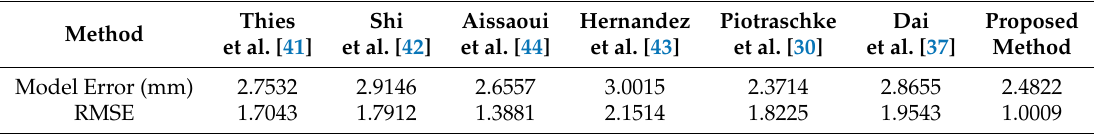
Table 2. Comparison of results with other state-of-the-art approaches. Model error over all mesh vertices (nearly 400,000) for all meshes in the ESRC